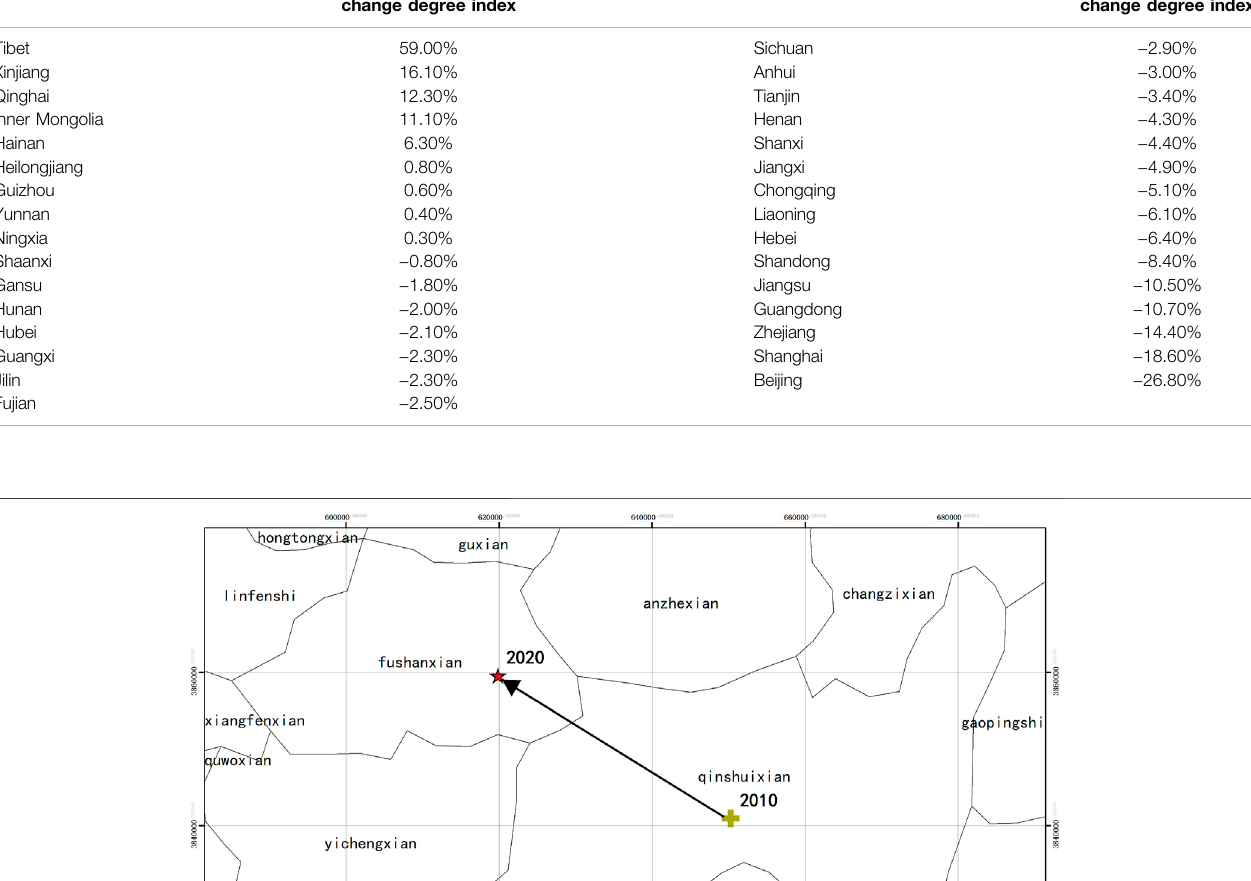
TABLE 3 | The dynamic change degree Index of cultivated land utilization rate of 31 regions in China. Province